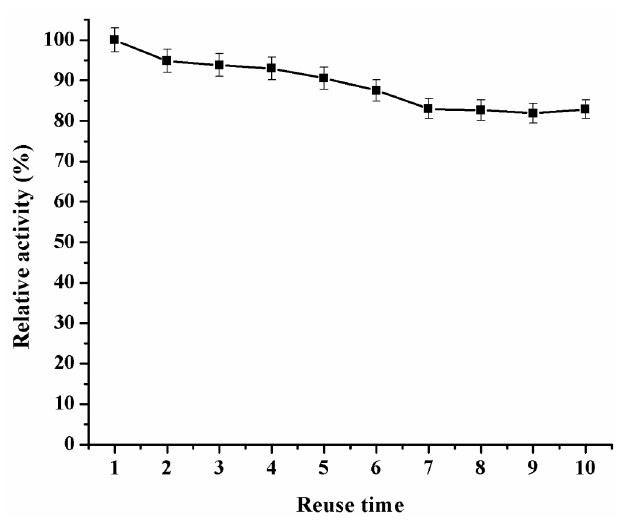
Figure 8. Reusability of immobilized lipase in resolution reaction. (Reaction conditions: 0.02 g immobilized BCL, 45 °C, 1 h).